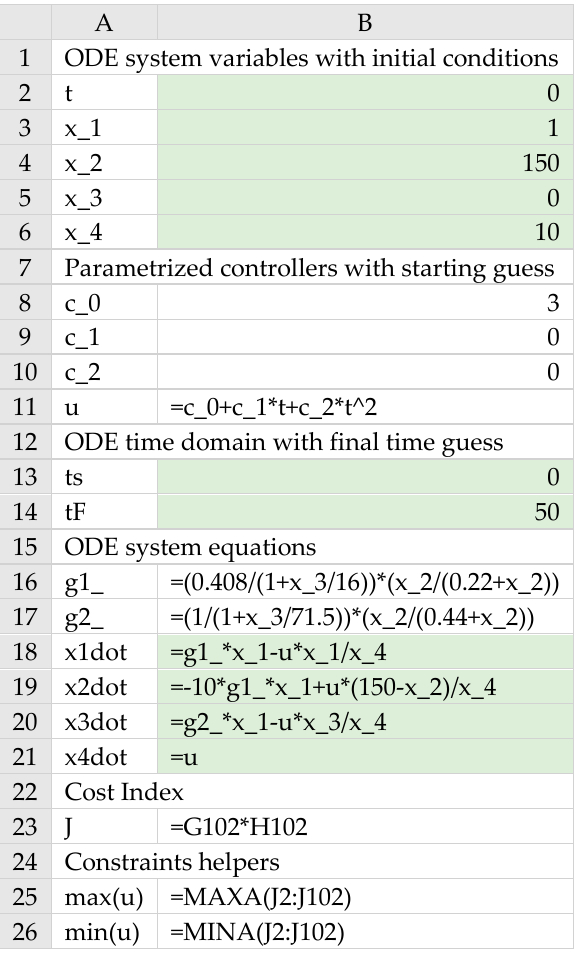
Figure 20. Spreadsheet parametrized model for problem 3.4. The colored ranges are inputs for IVSOLVE formula (37).